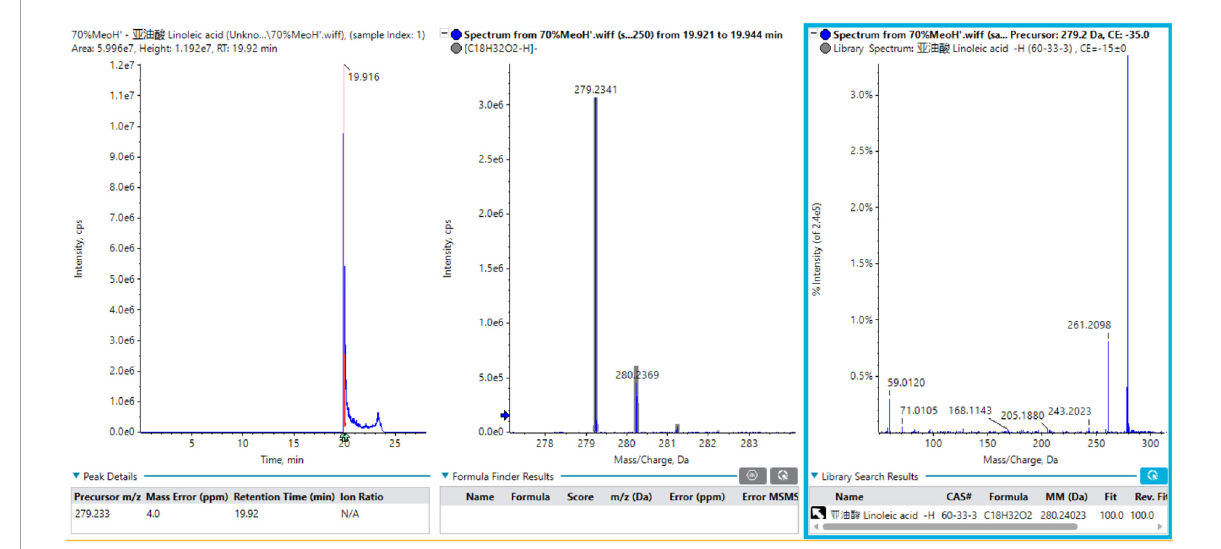
FIGURE1 The mass spectra, fragment information and Sciex OS screening interface of linoleic acid in negative